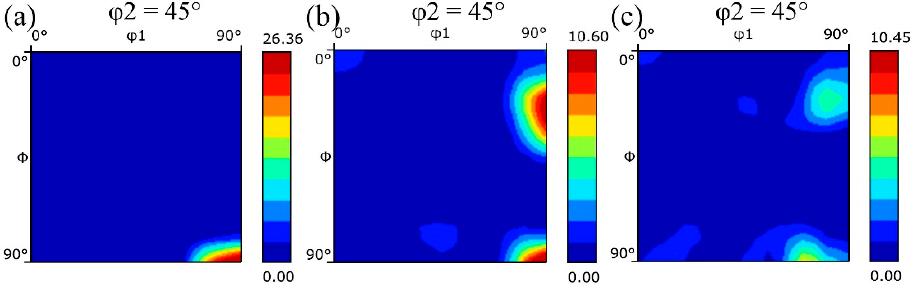
Figure 4. φ 2 = 45° ODF sections showing surface textures ( a ) 800 °C—88%, ( b ) 800 °C—78%, ( c ) 800 Figure 4. ϕ 2 = 45 ◦ ODF sections showing surface textures ( a ) 800 ◦ C—88%, ( b ) 800 ◦ C—78%, °C—67%. ( c ) 800 ◦